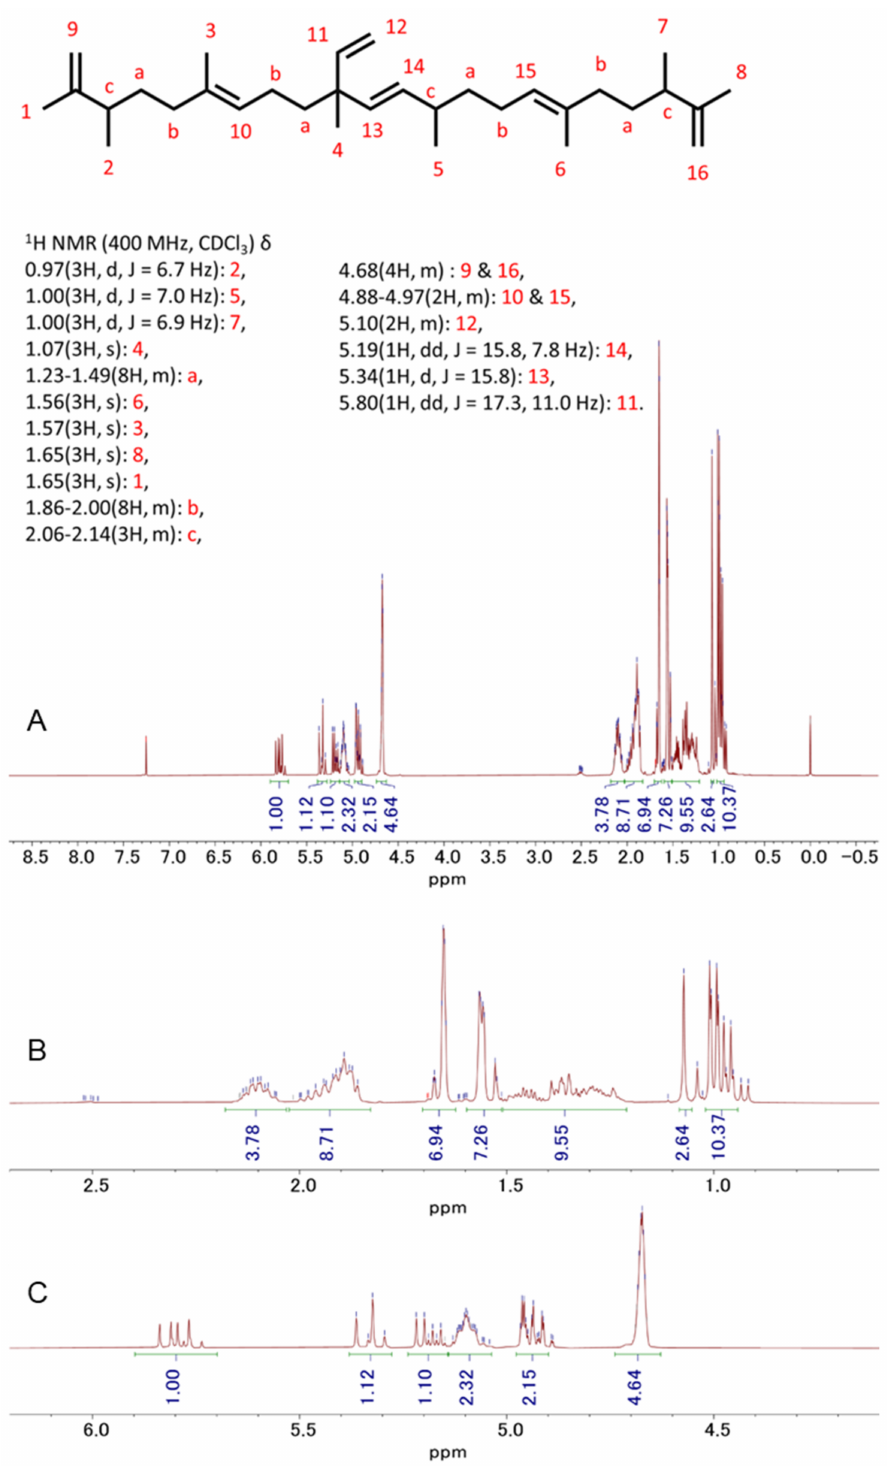
Figure 6. 1H-NMR spectra of C32 botryococcene in CDCl3 at 25 ◦ C: ( A ) whole spectrum; ( B , C ) partial spectra. 3.6. Me-Meijicoccene and C32 Botryococcene Treatment Regulated the Gene Expression Levels of Hair Growth